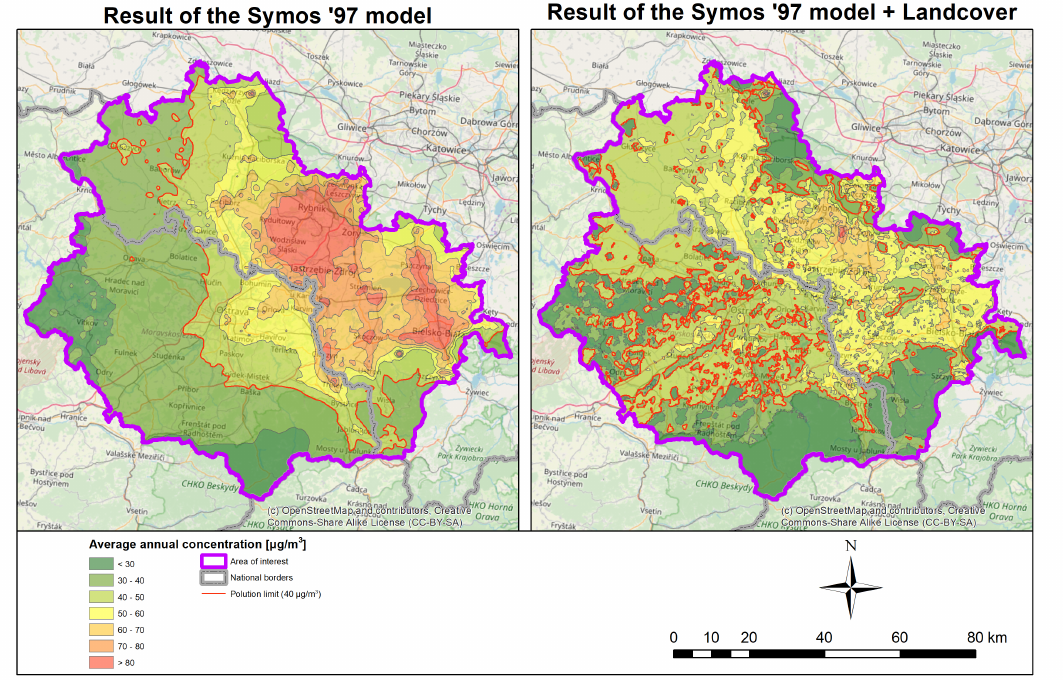
Figure 7. Comparison of model results’ spatial